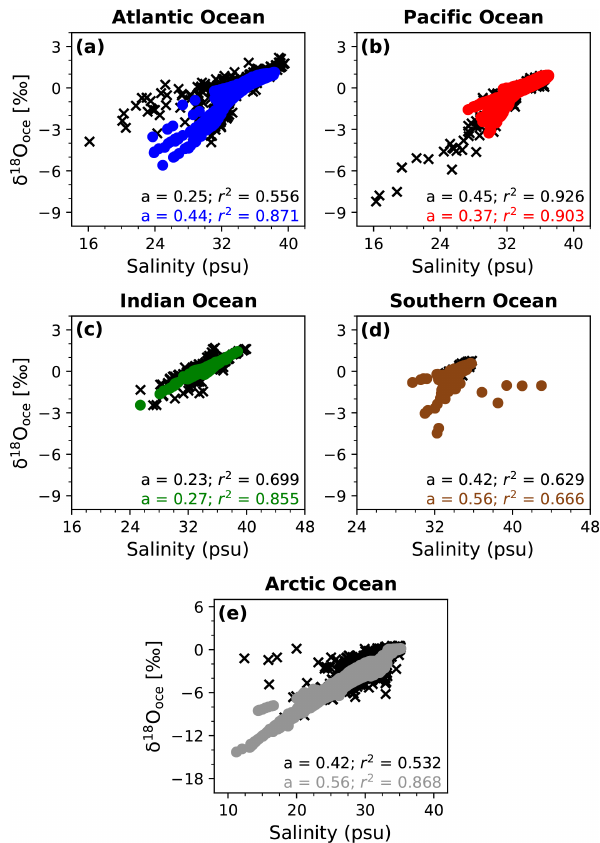
Figure 3. Scatter plots of δ 18 O in ocean surface water vs. surface salinity for the (a) Atlantic, (b) Pacific, (c) Indian, (d) Southern and (e) Arctic Ocean under PI conditions. The black crosses correspond to the data from the GISS database and the colored dots to the mod- eled values. The gradients and the correlation coefficients of the linear regression fits are given in the